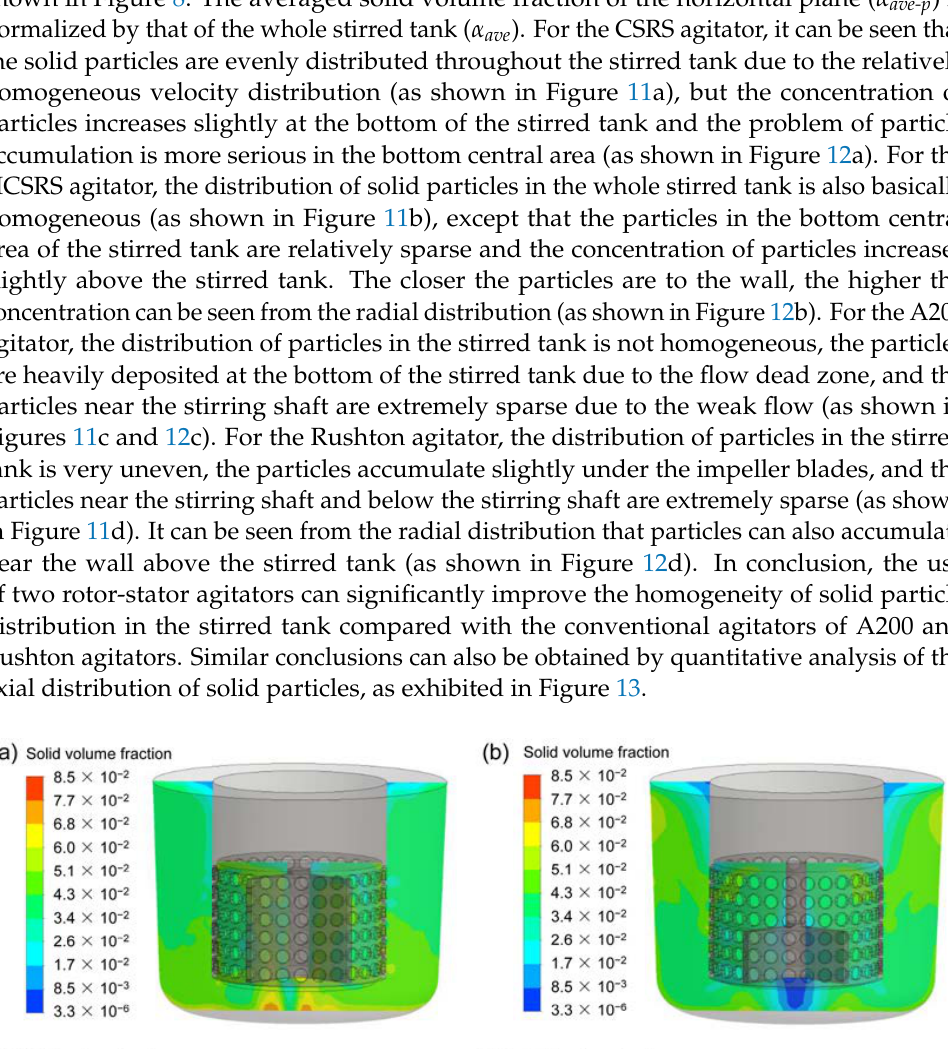
Figure 12. The distribution of solid volume fraction at different horizontal planes for the four types of agitators at the stirring speed of 400 rpm; ( a ) CSRS agitator; ( b ) HCSRS agitator; ( c ) A200 agitator; ( d ) Rushton agitator.